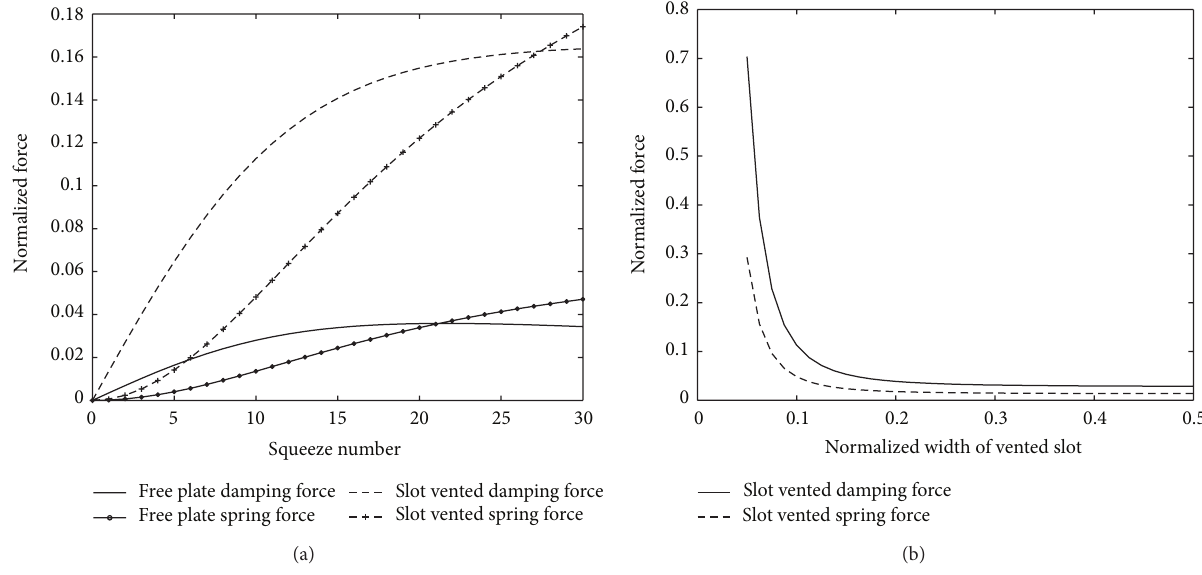
Figure 5: Result of an instance: (a) spring and damping forces (b) relationship of slot width and